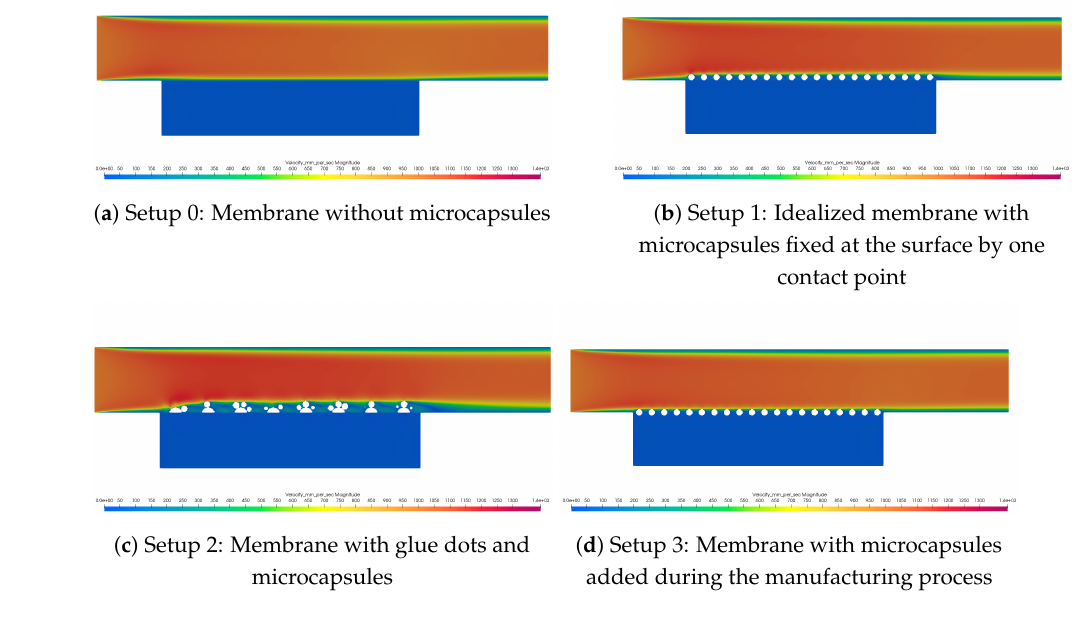
Figure 8. Overview of the velocity slices for the different